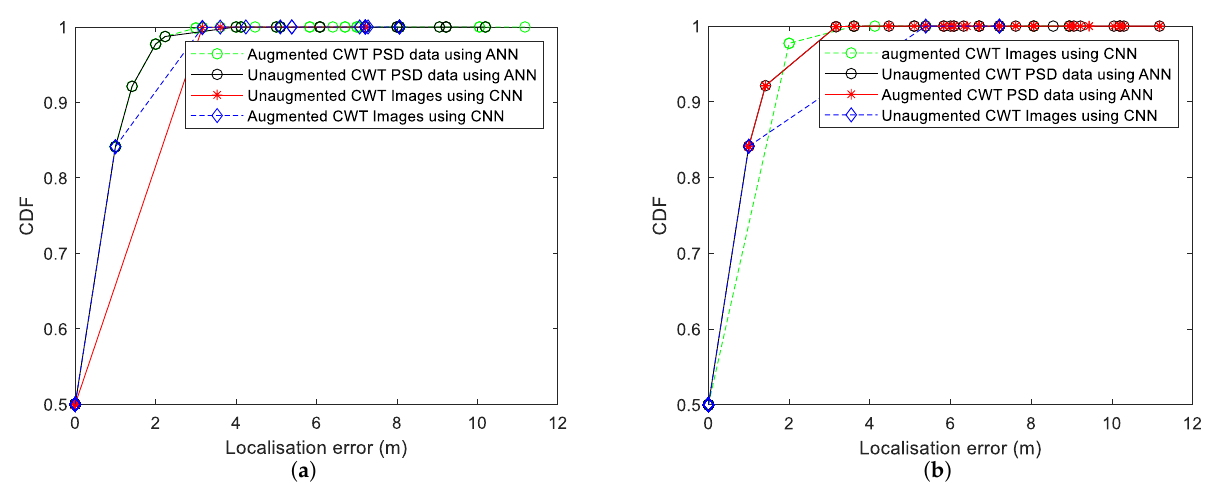
Figure 12. CDF of localization error based on ( a ) Morse-based feature sets and ( b ) Morlet-based feature